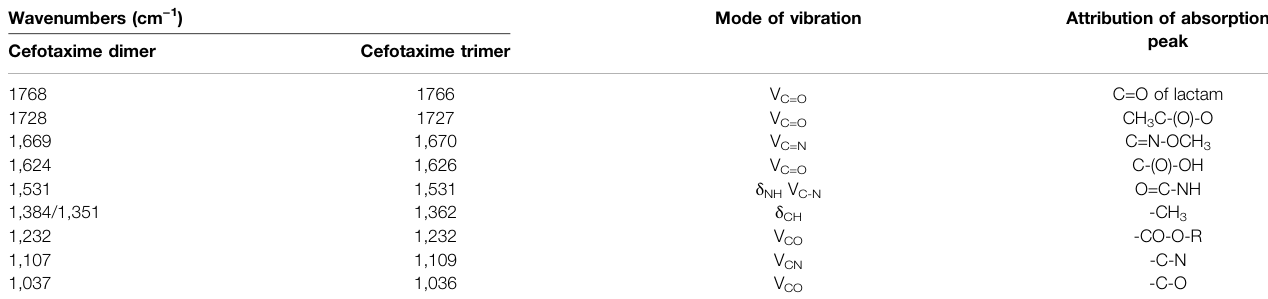
TABLE 1 | IR spectra of cefotaxime Dimer and cefotaxime Trimer.